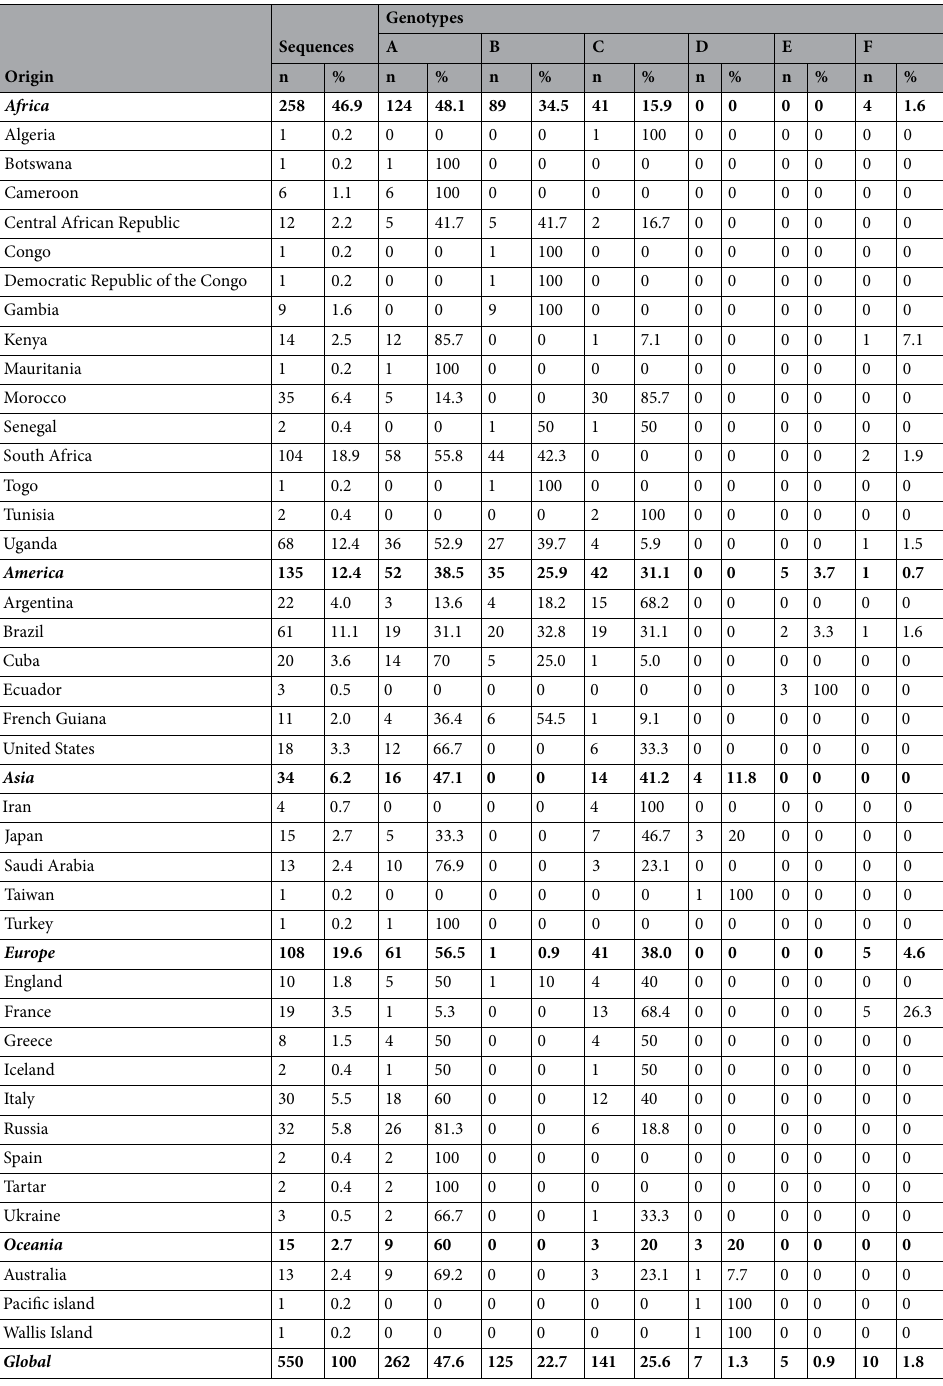
Table 1. Genotypic distribution of HHV-8 by geographic